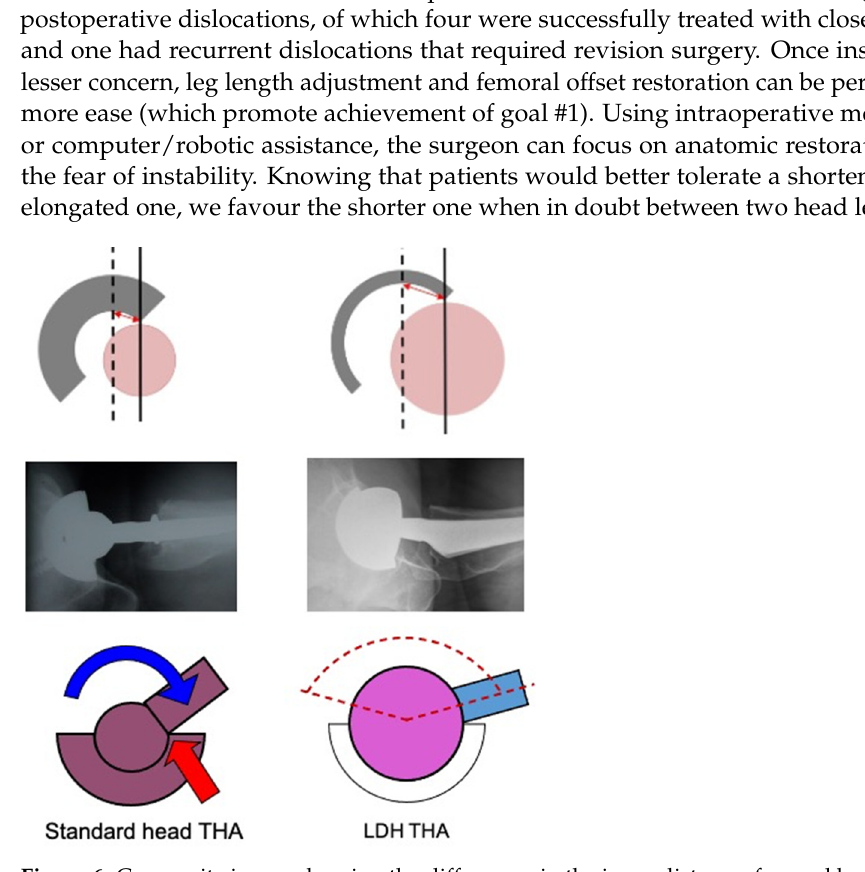
Figure 6. Composite image showing the differences in the jump distance, femoral head-neck offset, and impingement free range of motion between a standard femoral head and LDH.